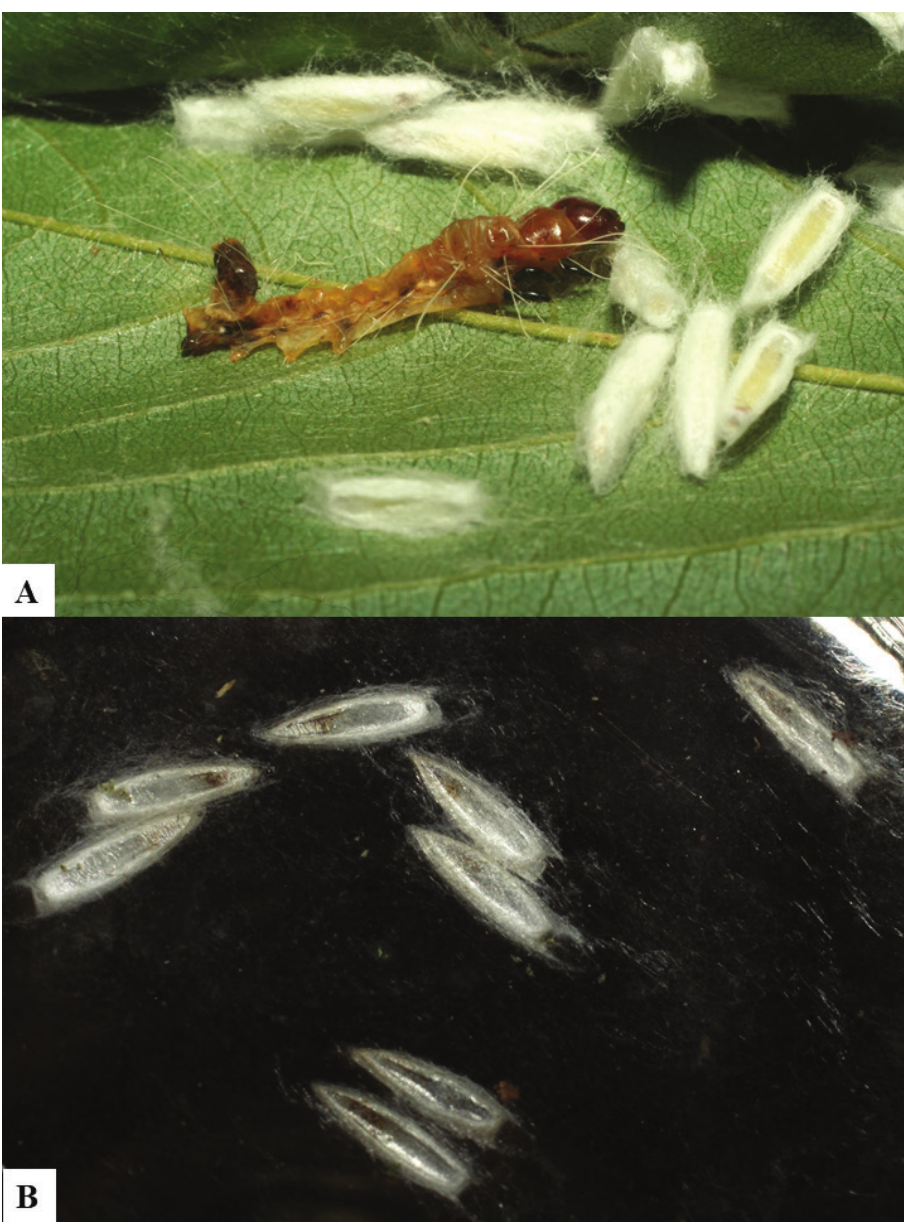
Figure 10. A, B Cocoons of Dolichogenidea alejandromasisi sp.